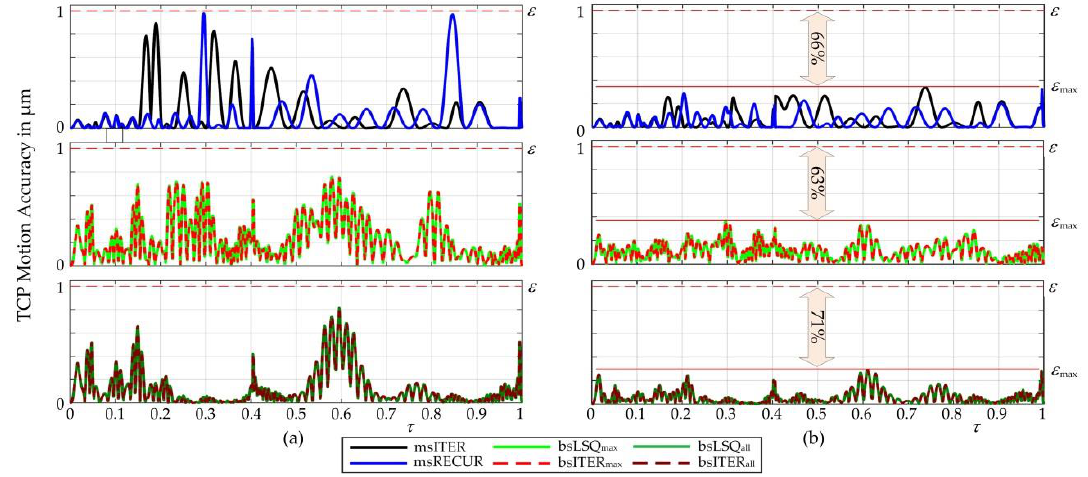
Figure 15. Motion accuracy of the calculated splines. ( a ) Using conventional an ( b ) simple motion preparation approach.